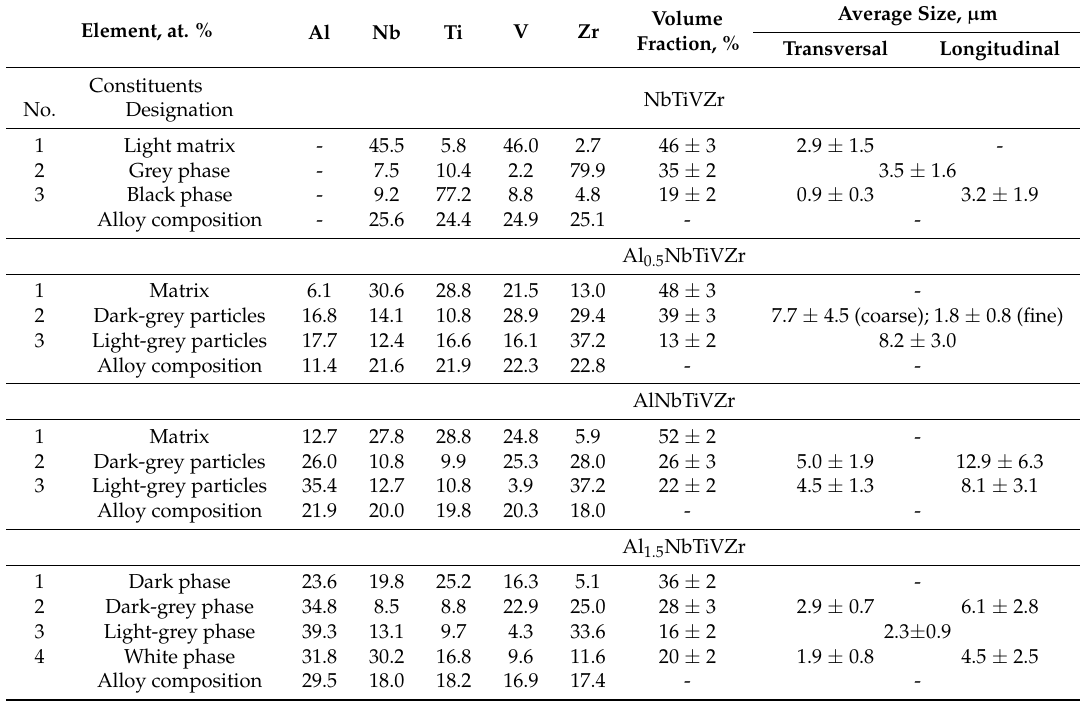
Table 2. Chemical compositions, volume fractions and dimensions of the constituents of the Al x NbTiVZr ( x = 0; 0.5; 1; 1.5) alloys after annealing at 1000 ◦ C for 100 h. Typical regions used for analysis are shown in Figure